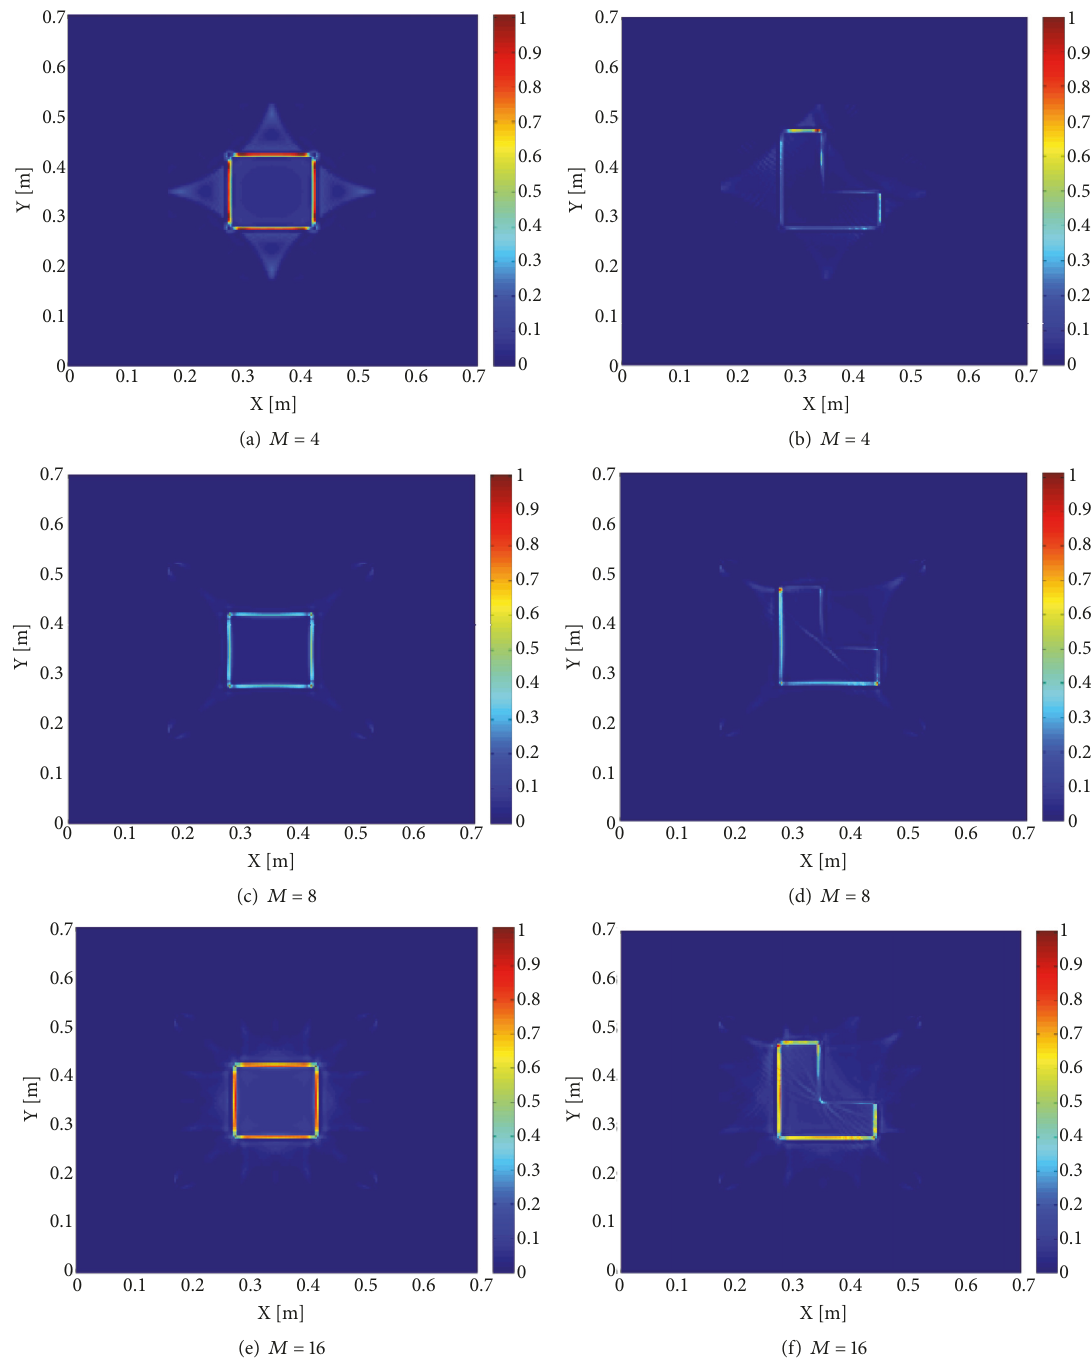
Figure 13: Imaging a square-like object (left) and an L-shape object (right) by M transmitters and 𝑁 = 16 receivers.